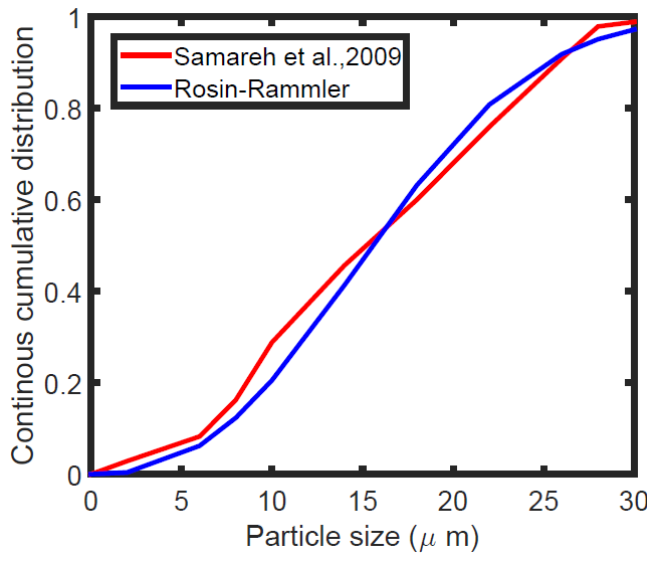
Figure 4. Particle size distribution